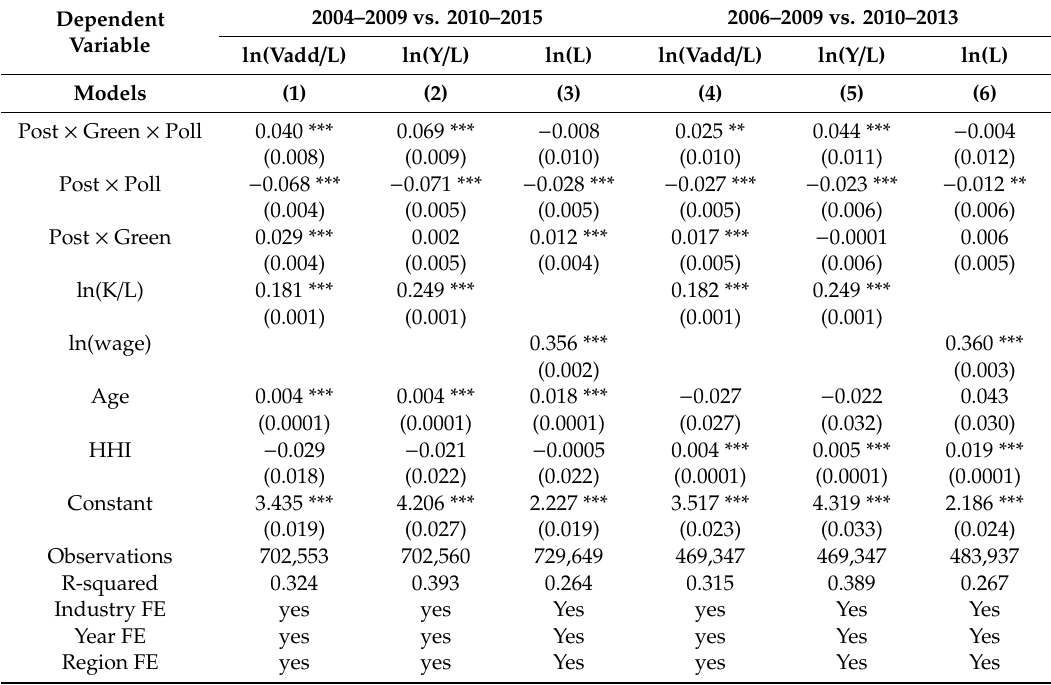
Table 4. Estimation results based on labor productivity and employment as dependent variables for the green sector in polluting